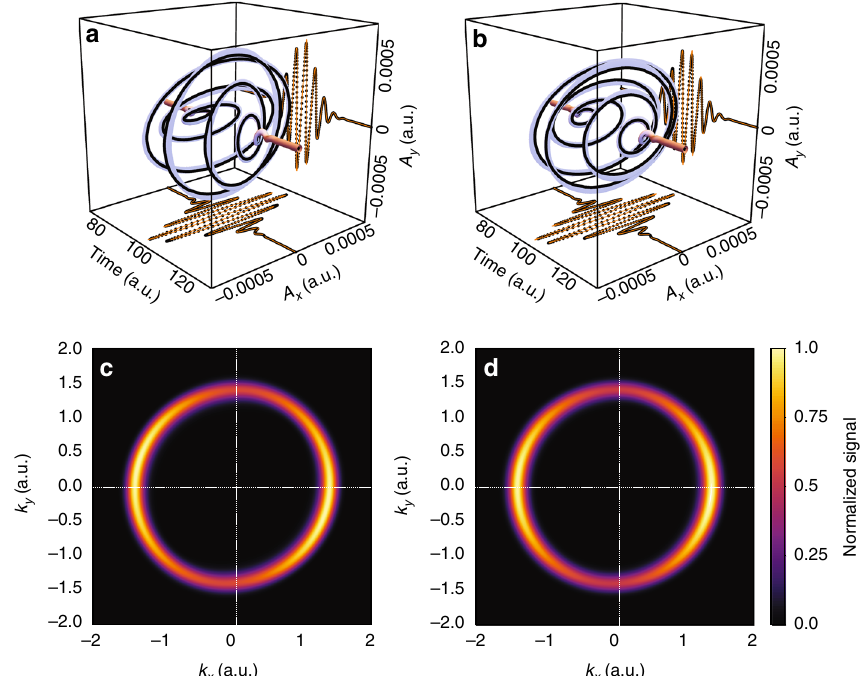
Fig. 2 Reconstruction of two pulses with time-dependent polarization states. a , b Complete reconstruction of the time-dependent polarization state of two 250 as pulses carried at 41 eV (vector potential is shown). Ellipticity varies from ε = 0.3 along the y -axis to ε = 0.625 along the x -axis for the pulse in ( a ), and from ε = 0.5 to ε = 0.9 along the y -axis for the pulse in ( b ), see text for details. Original (purple in three dimensional (3D), orange in two dimensional (2D)) and reconstructed pulses (black lines in 3D, black dots in 2D). Additionally, the pulse in ( b ) has a 15% admixture of unpolarized light (not shown). c , d Normalized angularly resolved one-photon spectrum generated in a hydrogen atom using the pulse ( a ) for panel ( c ) and pulse ( b ) for panel ( d